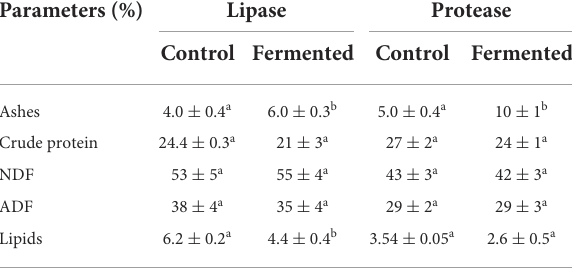
TABLE 3 Characterization of the fermented solid substrates after enzymatic extraction. Parameters (%) Lipase Protease Control Fermented Control Fermented Ashes 4.0 ± 0.4 a 6.0 ± 0.3 b 5.0 ± 0.4 a 10 ± 1 b Crude protein 24.4 ± 0.3 a 21 ± 3 a 27 ± 2 a 24 ± 1 a NDF 53 ± 5 a 55 ± 4 a 43 ± 3 a 42 ± 3 a ADF 38 ± 4 a 35 ± 4 a 29 ± 2 a 29 ± 3 a Lipids 6.2 ± 0.2 a 4.4 ± 0.4 b 3.54 ± 0.05 a 2.6 ± 0.5 a Values represent the mean and SD from at least two independent experiments. Values of controlandfermentedsubstrateforeachenzymewiththesameletterarenotsignificantly different( p >